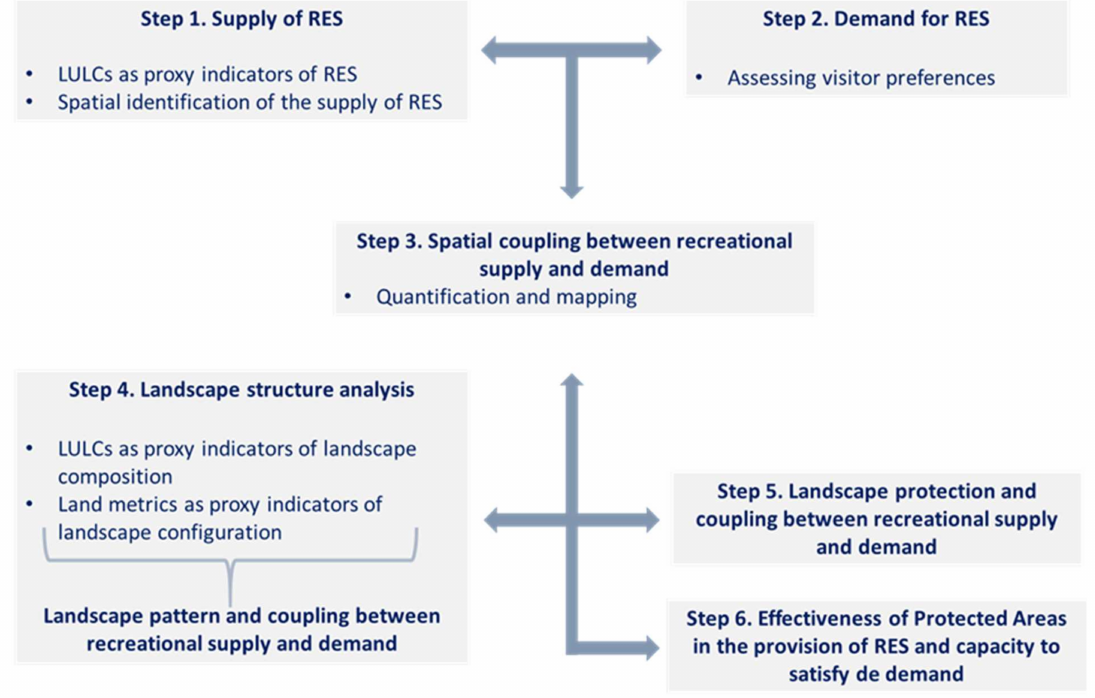
Figure 2. Schematic description of the steps followed in the methodological